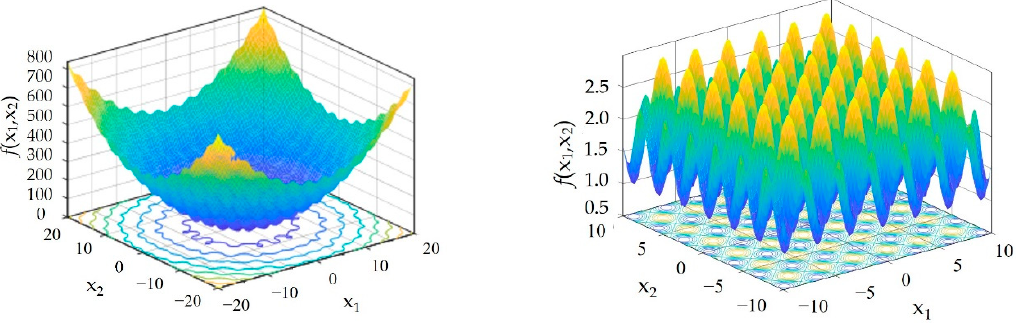
The figures of multi-modal test functions. ( a ) The egg crate function; ( b ) the periodic function.